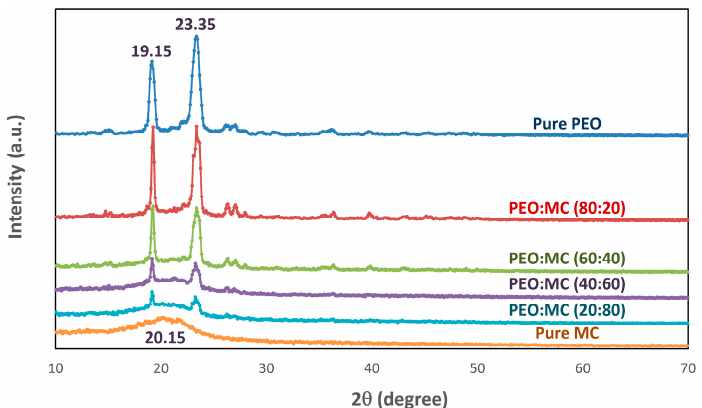
Figure 1. The X-ray diffraction pattern for pure polyethylene oxide (PEO), pure methylcellulose (MC) and their blend with different weight ratio.